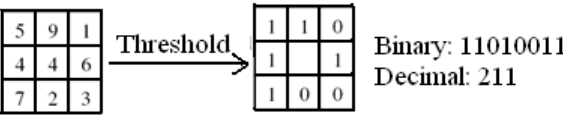
Figure 1. An example of basic LBP operator.